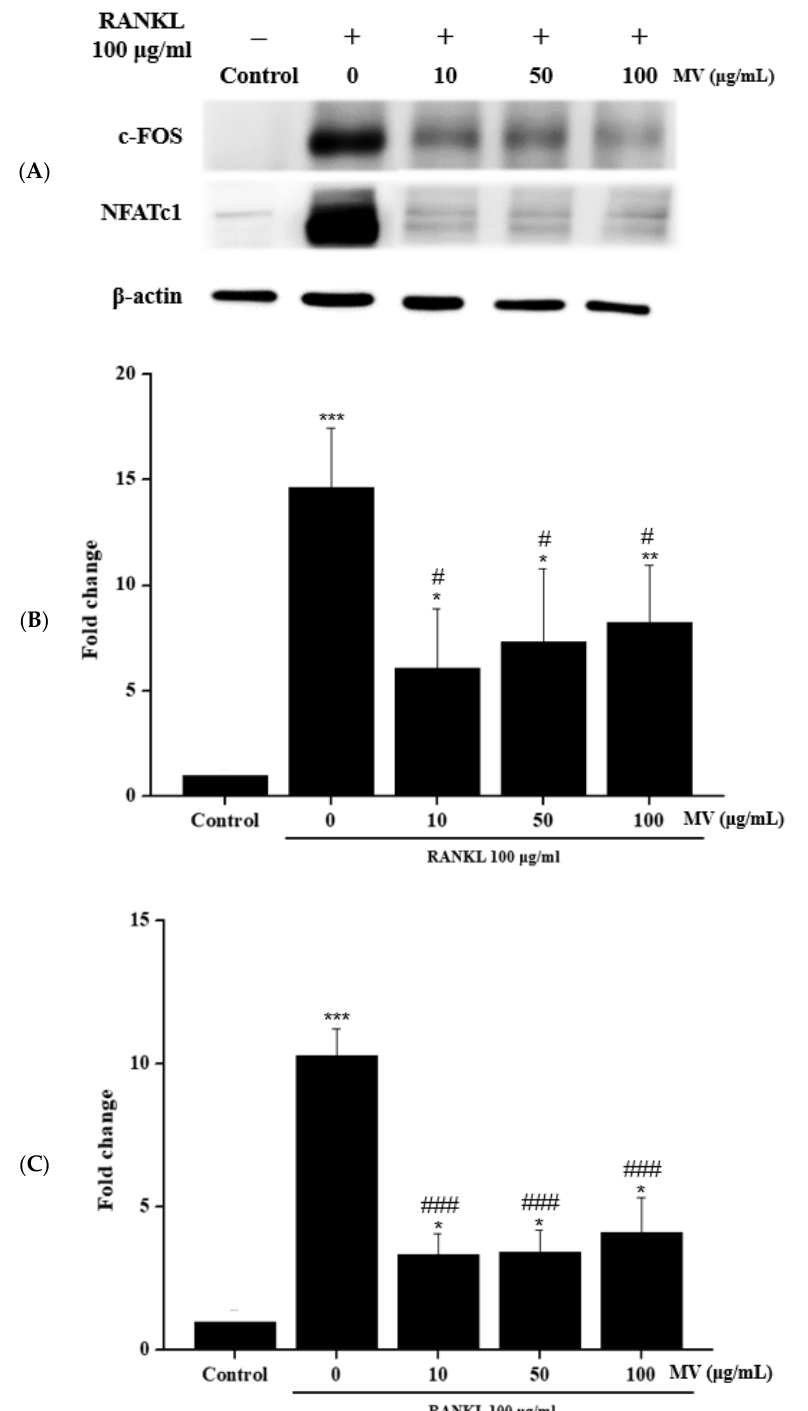
Figure 5. Osteoclastogenesis-related protein contents in RANKL-induced Raw264.7 cells administered with different dosages of dried mulberry vinegar for five days.; ( A ) Western blot of c-Fos and NFATc1; ( B ) Relative contents of c-Fos; ( C ) Relative contents of NFATc1; Bars and error bars represented mean ± standard deviation ( n = 3). * Significantly different from the Control at p < 0.05, ** at p < 0.01, and *** at p < 0.001. # Significantly different from the 0 μ g/mL MV treatment at p < 0.05 and ### at p < 0.001.